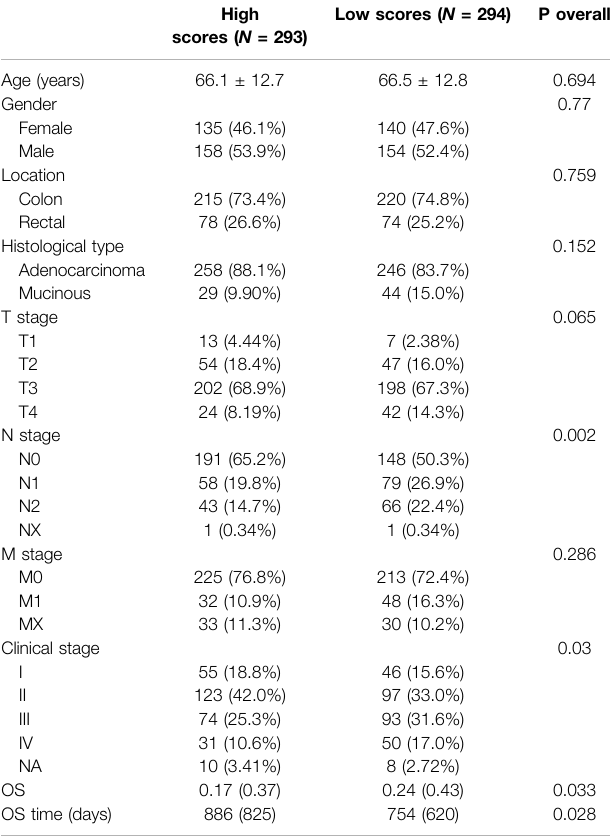
TABLE 1 | Comparison of clinical feature between high and low mRNAsi